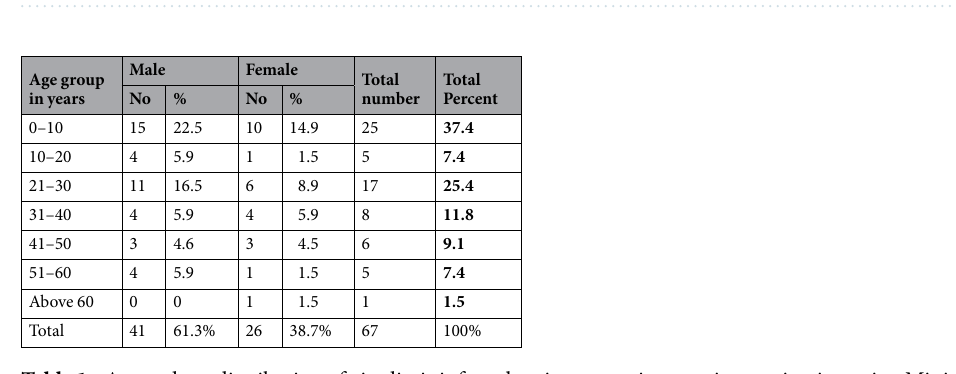
Table 1. Age and sex distribution of giardiasis infected patients on microscopic examination using Mini-